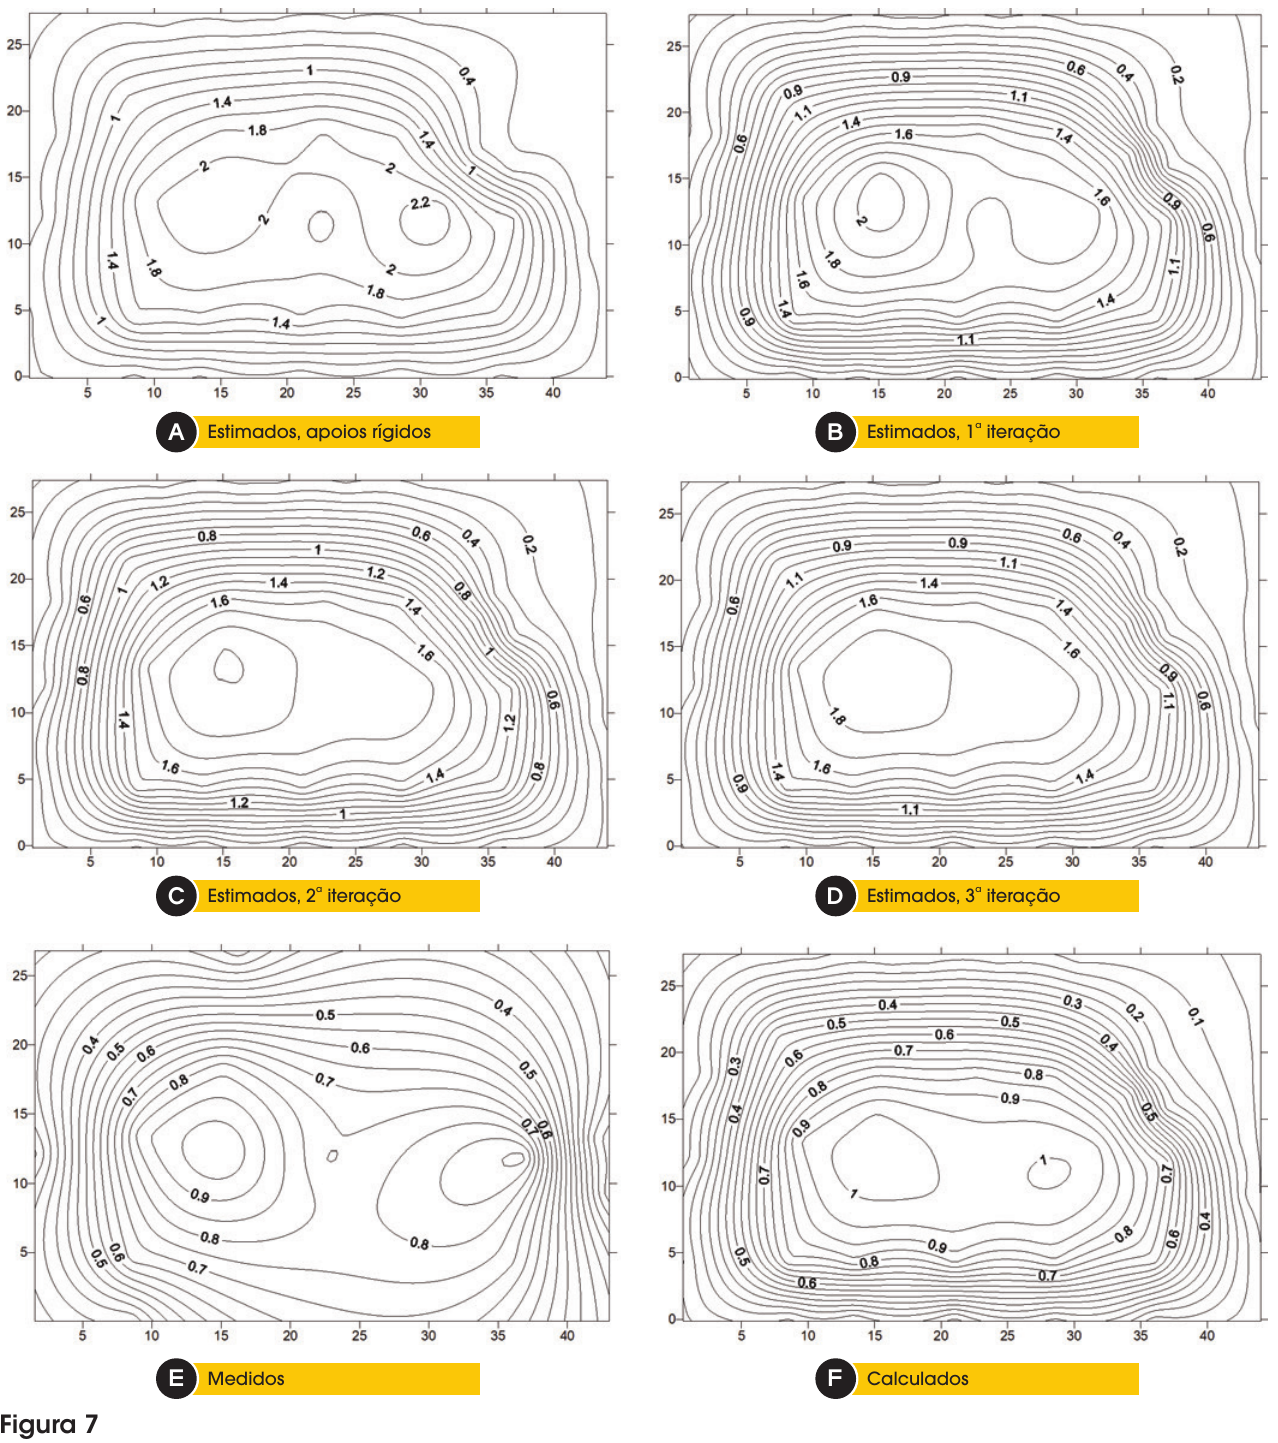
Figura 7 Curvas iso-recalques para a 6 a etapa (em